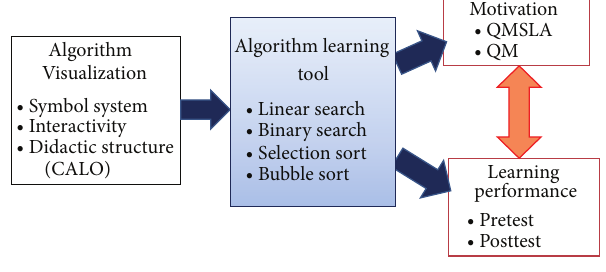
Figure 1: Research